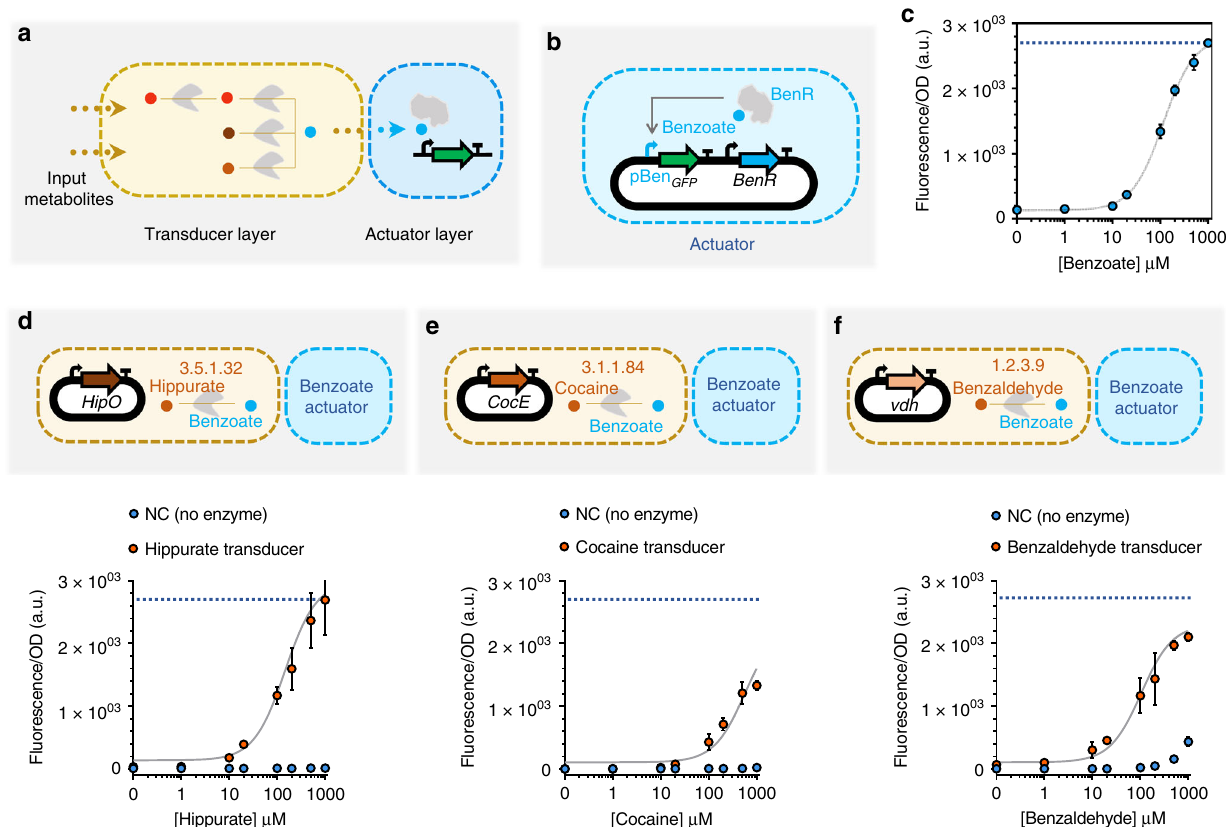
Fig. 1 Whole-cell actuator and metabolic transducers. a Designed synthetic metabolic circuits using Retropath 36 or Sensipath 37 consist of a transducer layer and an actuator layer. b Open-loop circuit construction of the benzoate actuator, which is used downstream of transducer metabolic circuits in this work. For the open-loop circuit, the gene encoding transcription factor (TF) is expressed constitutively under control of the promoter J23101 and RBS B0032. c Dose-response plot of the open-loop circuit for the benzoate actuator. The gray curve is a model- fi tted curve (see Methods section) for the open- loop circuit. d – f Whole-cell metabolic transducers for hippurate ( d ), cocaine ( e ) and benzaldehyde ( f ) represented in dose-response plots (orange circles) and their associated dose-response when there is no enzyme present (blue circles). The blue dotted lines refer to the maximum signal from the actuator ( c ). The transducer output, benzoate, is reported through the open-loop circuit actuator. The genes encoding the enzymes are expressed under constitutive promoter J23101 and RBS B0032. All data points and the error bars are the mean and standard deviation of normalized values from measurements taken from three different colonies on the same day. Source data are provided in the Source Data fi